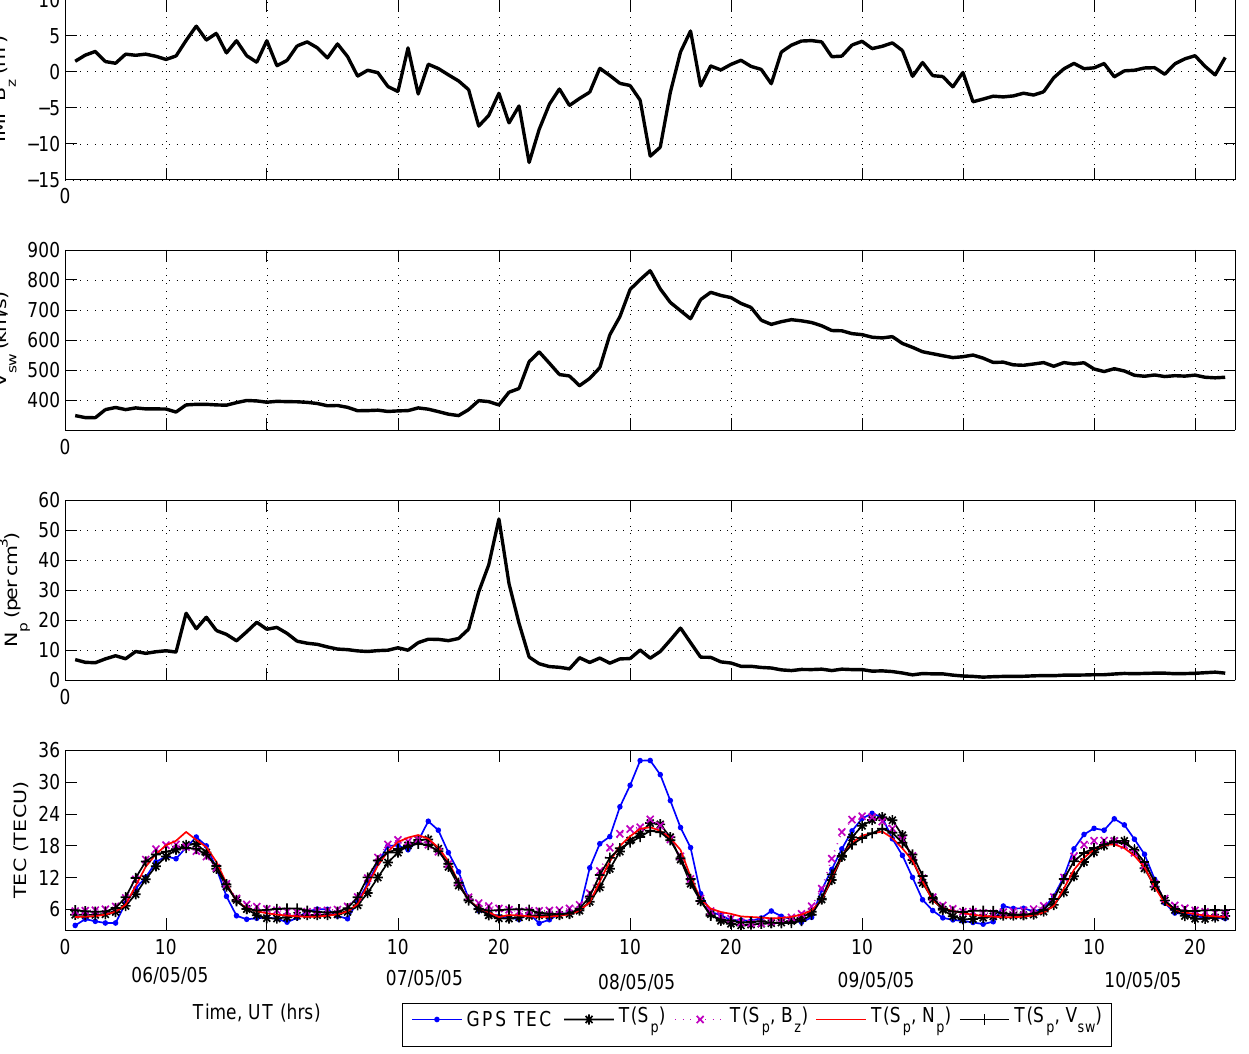
Fig. 7. Variations of the considered solar wind parameters and TEC values (derived and predicted) during 6–10 May 2005.